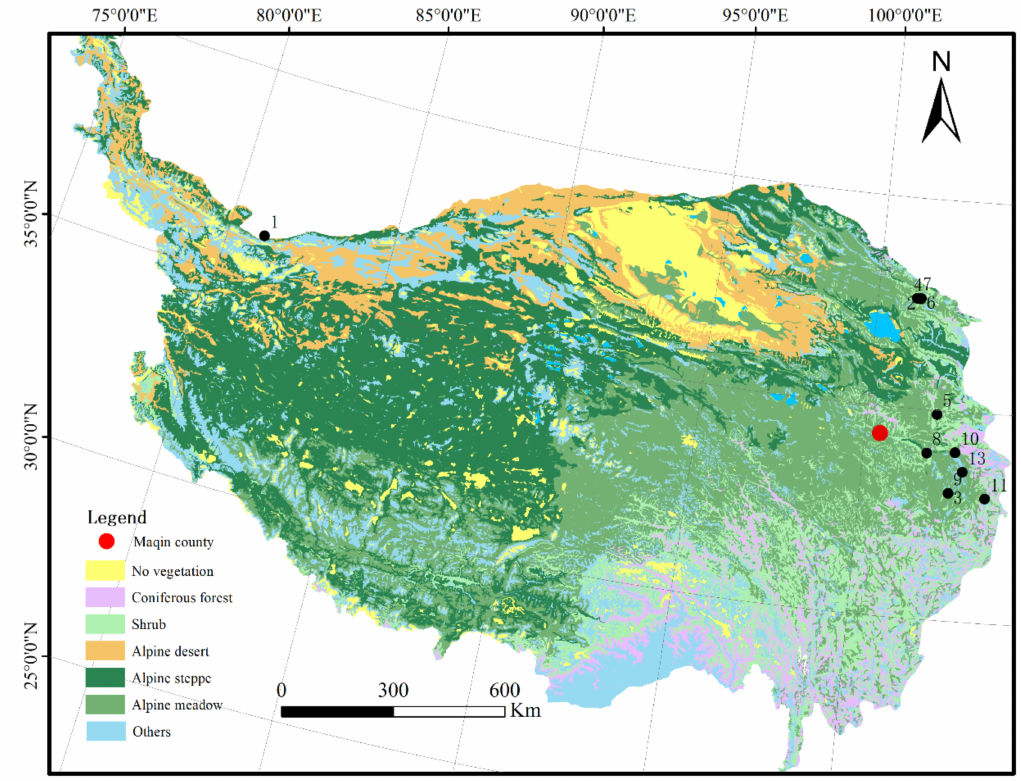
Figure 1. Field measurement site in Maqin county and meta-analysis research sites on Tibetan Plateau including main vegetation